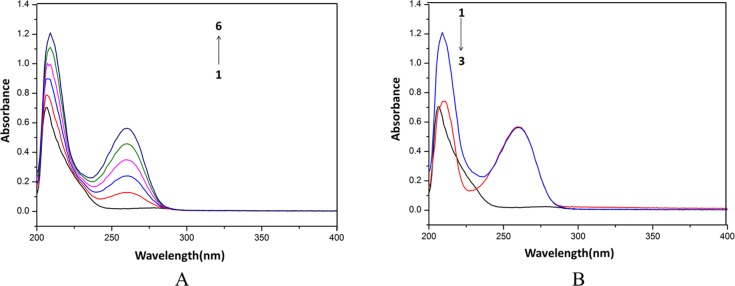
Effects of cordycepin on HSA by UV spectra.A: The concentration of HSA was 0.5 μM while the cordycepin concentration corresponding to 0, 10, 20, 30, 40 and 50 μM from (1 to 6). B: 1, 0.5 μM HSA + 50 μM cordycepin; 2, 50 μM cordycepin; 3, 0.5 μM HSA.